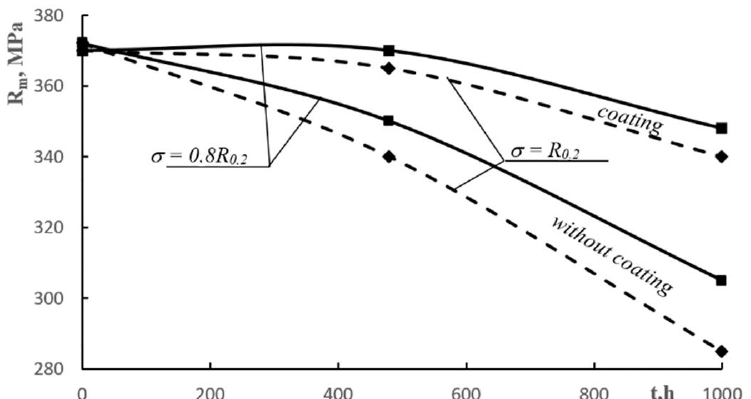
Figure 8. Influence of the corrosive environment and stress level on the yield strength reduction of AlMg6 alloy samples without coatings and with coatings.